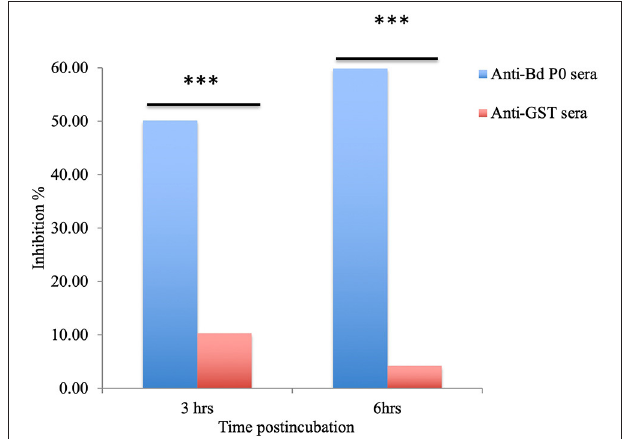
FIGURE 5 | Babesia divergens invasion inhibition assay. After 3 and 6h of culture, parasitemia was determined. *** p < 0.05 shows that the group that got BdP0 antibodies differed significantly from the group that received anti-GST IgG. The results are those of two separate